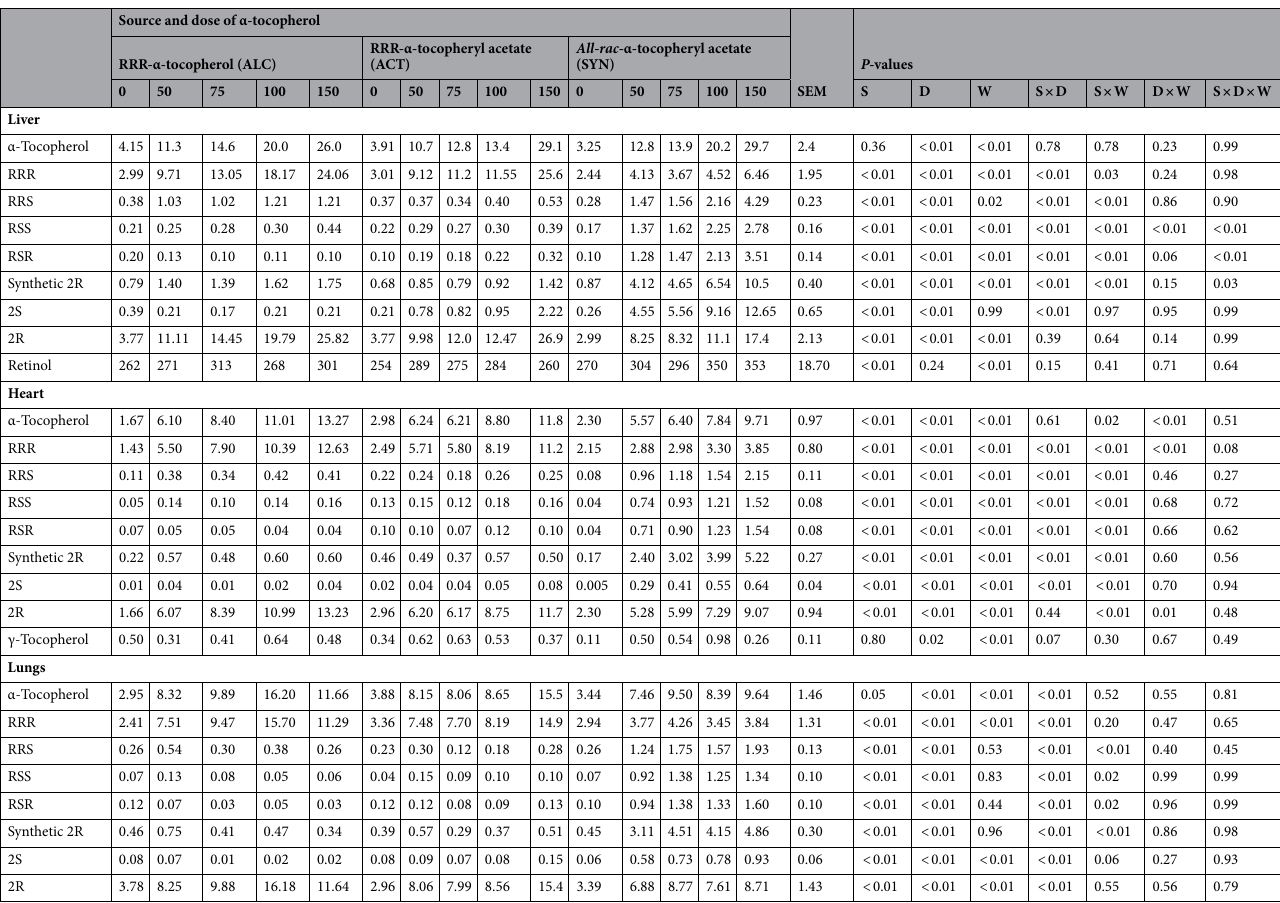
Table 3. Fat-soluble vitamins and α-tocopherol stereoisomers of liver (µg/g), heart (µg/g) and lungs (µg/g) of mink kits fed different sources (ALC, ACT and SYN) and doses of α-tocopherol (0, 50, 75, 100 and 150 mg/kg of diet). Synthetic 2R = Summation of synthetic 2R configuration of α-tocopherol stereoisomers ( Ʃ RRS, RSS, RSR), 2S = Summation of S configuration of α-tocopherol stereoisomers, 2R = Summation of R configuration of α-tocopherol stereoisomers, S = Effect of source, D = Effect of dose, W = Effect of weeks, S × D = Interaction between source and dose, S × W = Interaction between source and weeks, D × W = Interaction between dose and weeks, S × D × W = Interaction between source, dose and weeks. Presented values in Table are LS-means of weeks 3 and 6. SEM for the dose 0 in ALC, ACT and SYN is slightly higher. Presented P -values are from type-2